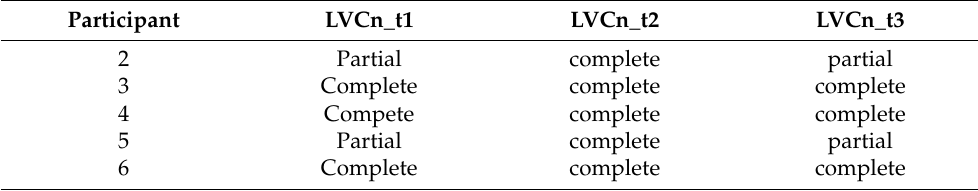
Table 30. LVC, nectar 10 mL, individual descriptions at three assessment time